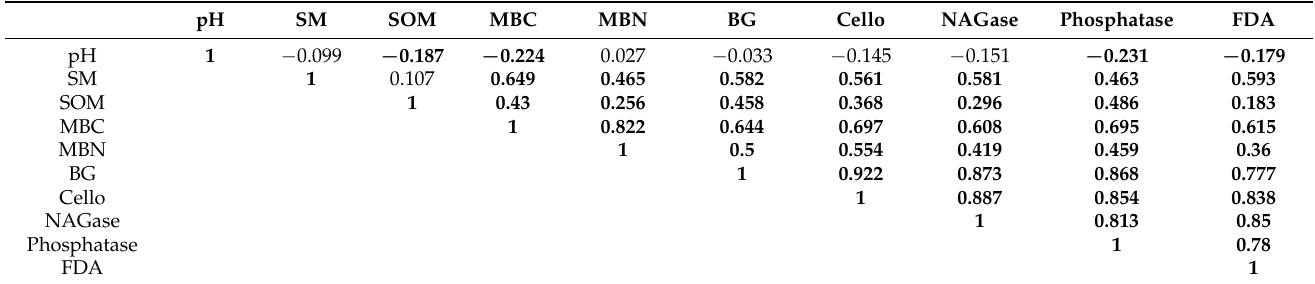
Table 4. Correlation matrix of chemical and biological traits in 0–5 cm soil